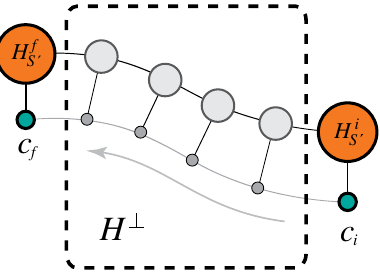
FIG. 11. Structure of the Hamiltonian. The Hamiltonian of the extended system S 0 ¼ SB and the control has the form ⊗ j c ⊗ j c H H i c H f c H ⊥ . Here, H i and S 0 C ¼ i ih i j þ f ih f j þ S 0 S 0 S 0 H f are the initial and final Hamiltonians, respectively, and S 0 j c i i ; j c f i the corresponding orthonormal control states. If the control is in state j c , the Hamiltonian of S 0 is H i , while it is H f i i S 0 S 0 if the control is in state j c . The Hamiltonian H ⊥ , which has i i ⊗ j c ⊗ j c c c orthogonal support to H i and H f , corre- i ih i j f ih f j S 0 S 0 sponds to possible intermediate stages. In the proofs of our fluctuation theorems, H ⊥ plays no particular role. However, it can x Þ , e.g., via a be used to simulate a path of Hamiltonians H S 0 ð discretization [see Appendix G 3